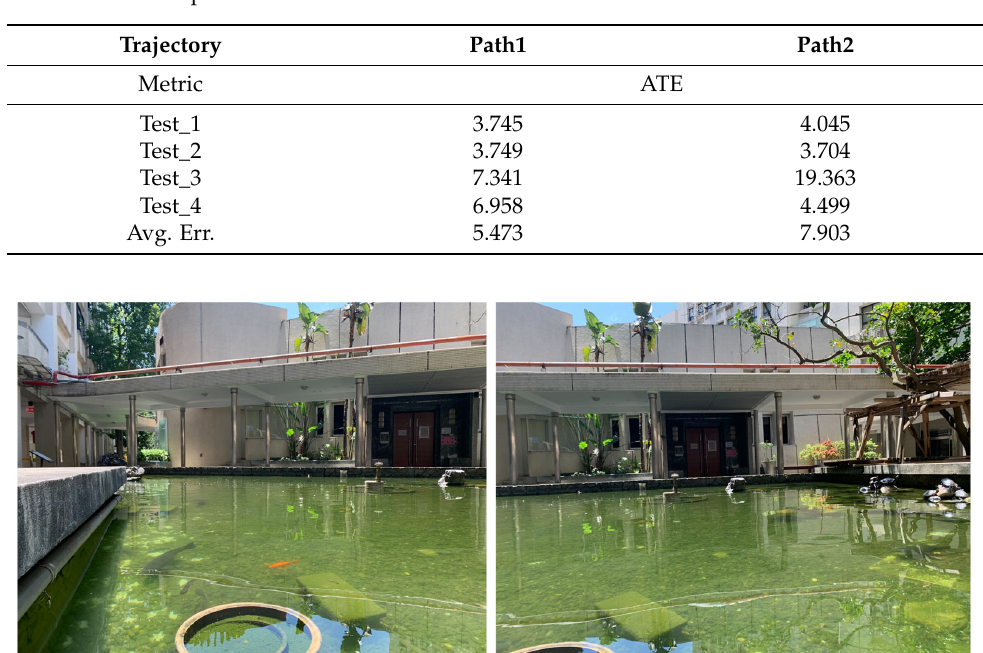
Table 1. Detailed specifications of the feedback module.